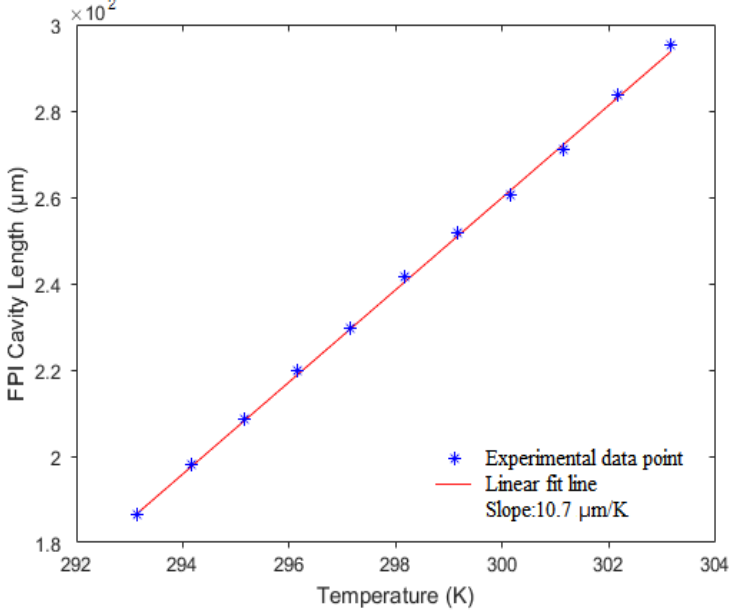
Figure 7. Measured cavity-length of FPI at different temperature with a constant pressure of 10 kPa.